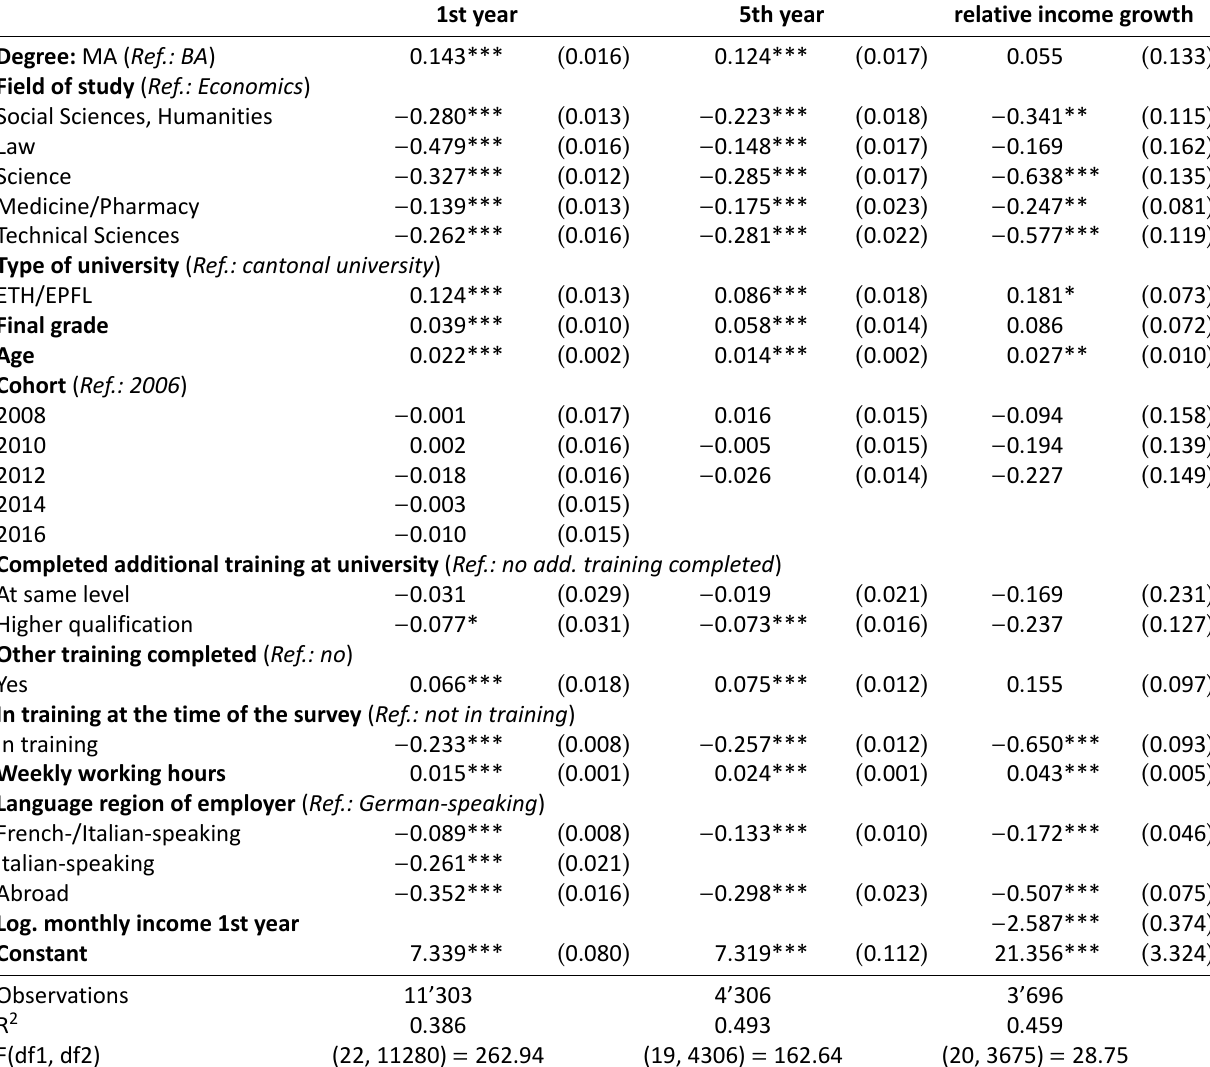
Table A7. Men’s monthly income (log.) in the first and fifth year after graduation and relative income growth; OLS-models. 1st year 5th